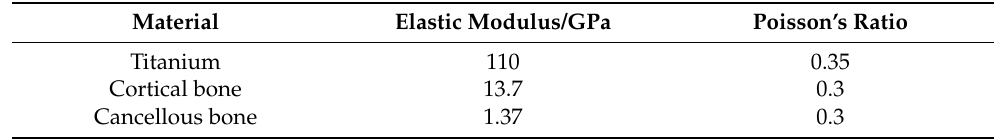
Table 2. Related parameters of implant-bone tissue material Table 1. Basic unit model parameters of each sector structure.